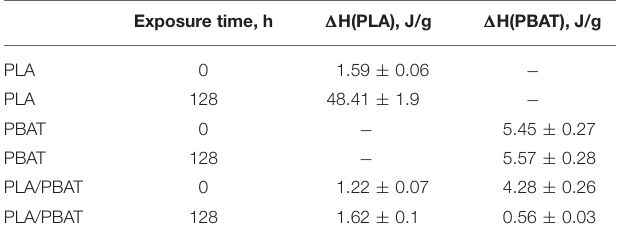
TABLE 1 | Enthalpy of fusion of pristine (unirradiated) and photooxidized (128h) samples. Exposure time,